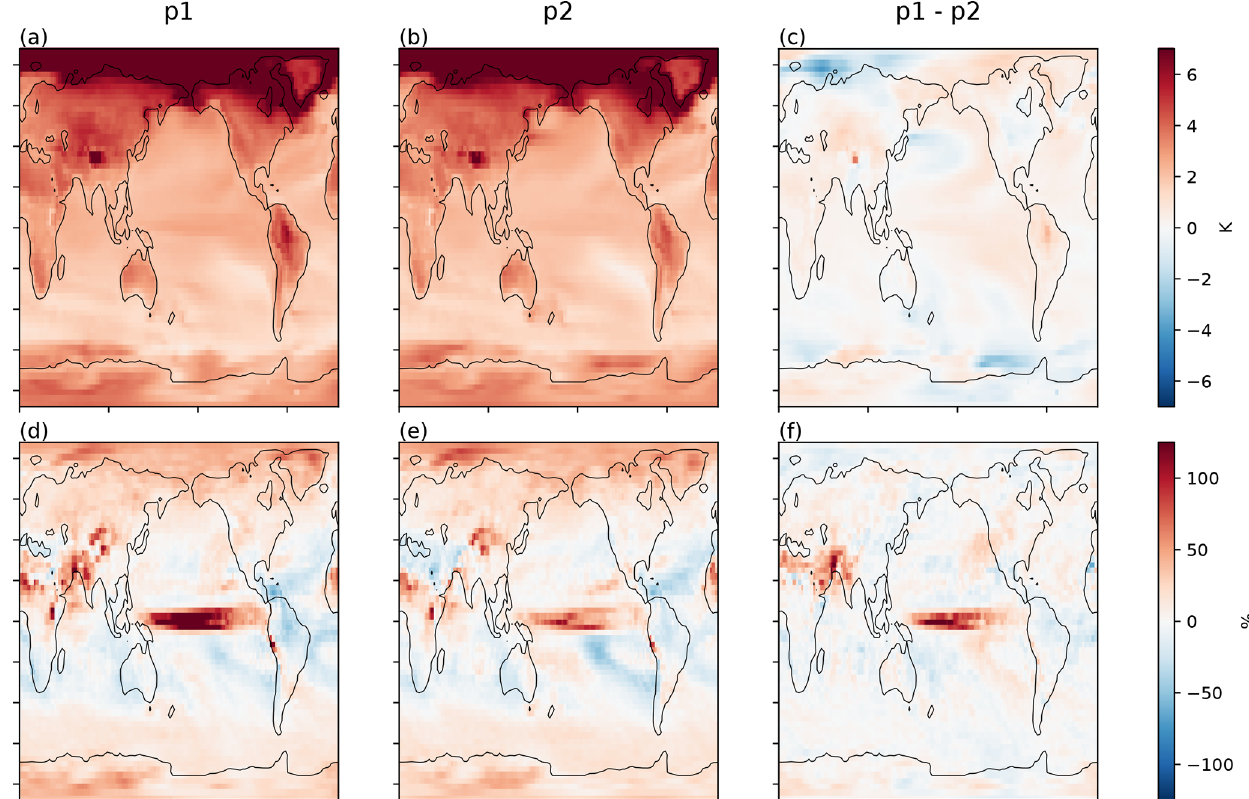
Figure E4. Perturbation of surface air temperature (a, b) and precipitation (d, e) computed as the mean over the 20 years centred on CO 2 doubling in the 1pctCO2 experiment, minus the mean from 200 years of the piControl simulation of the p1 (a, d) and p2 (b, e) model variants, and the differences between p1 and p2 (c, f)